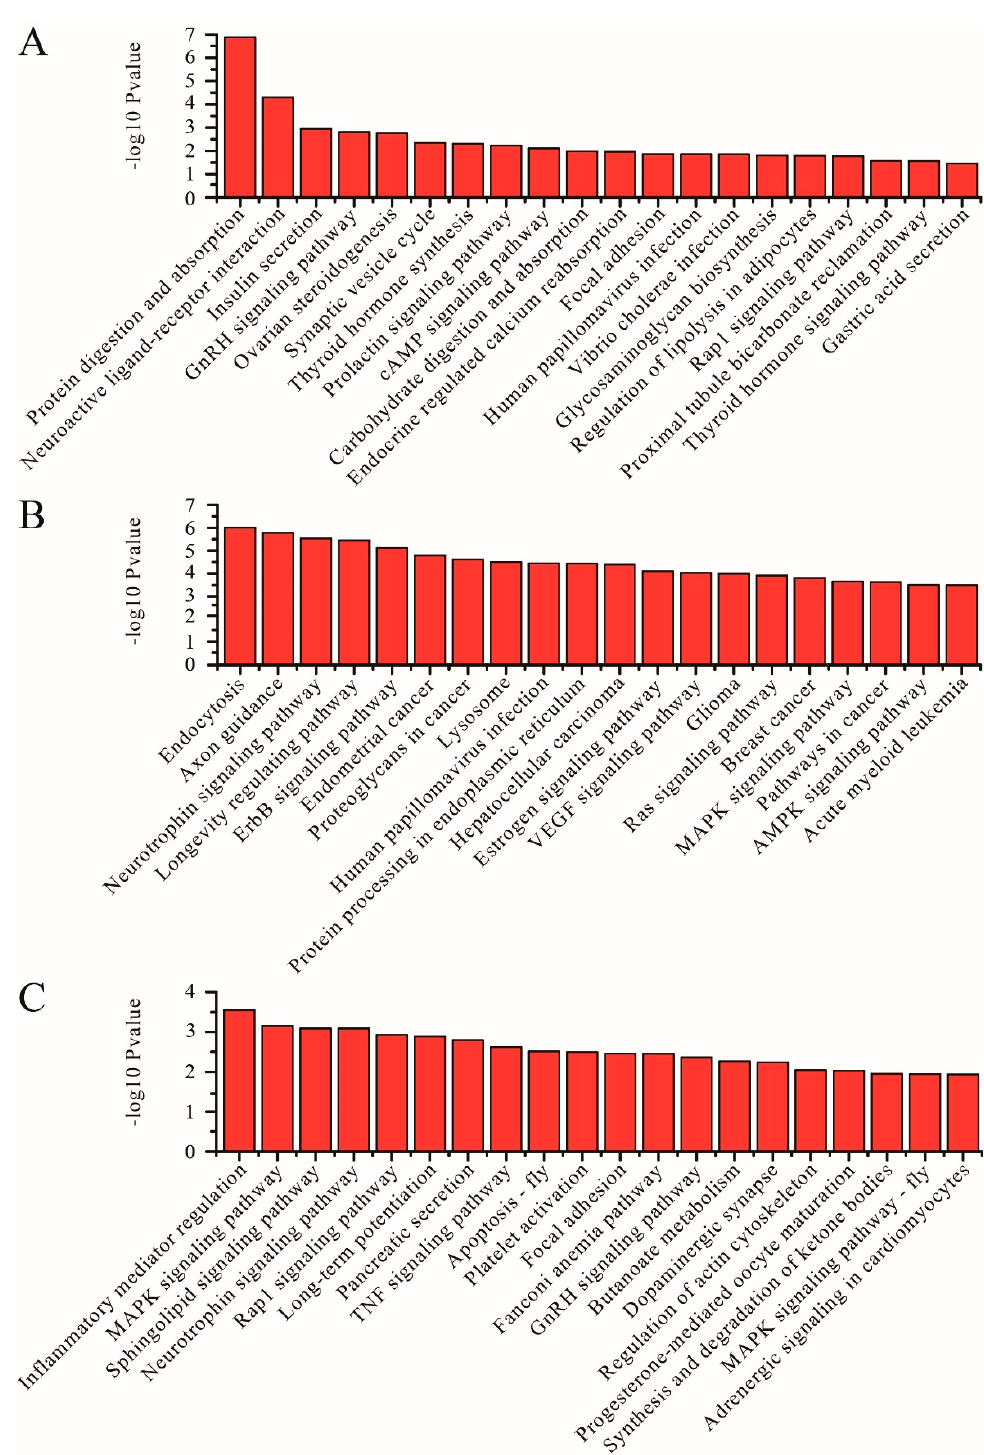
Figure 3. KEGG analyses of di ff erentially expressed genes between the SP and LP groups. ( A ) The top 20 KEGG enrichment pathways for di ff erentially expressed mRNAs between the SP and LP groups. ( B ) The top 20 KEGG enrichment pathways for di ff erentially expressed lncRNA target genes between the SP and LP groups. ( C ) The top 20 KEGG enrichment pathways for di ff erentially expressed circRNA host genes between the SP and LP